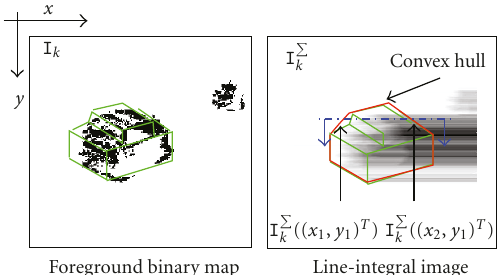
Figure 6: Illustration of the vision likelihood computation. The 3D model of the vehicle (shown in green/clear) is reprojected onto the image generated from the background-shape extraction. This projection is approximated by its convex hull (shown in red/dark on the right image). The likelihood calculation proceeds in a line- by-line integral image of the log-likelihood